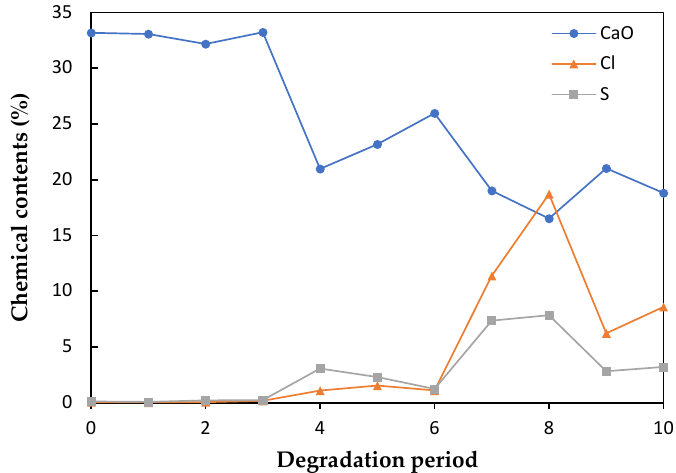
Figure 3. CaO, Cl and S on degraded concrete beam surfaces in 0–10 degradation periods.